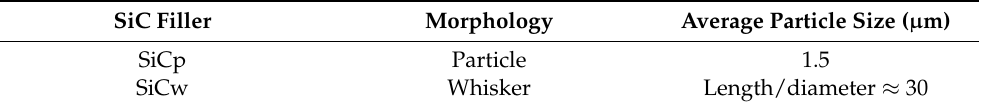
Table 1. The material parameters of SiC fillers. SiC Filler Morphology Average Particle Size ( µ m) SiCp Particle 1.5 SiCw